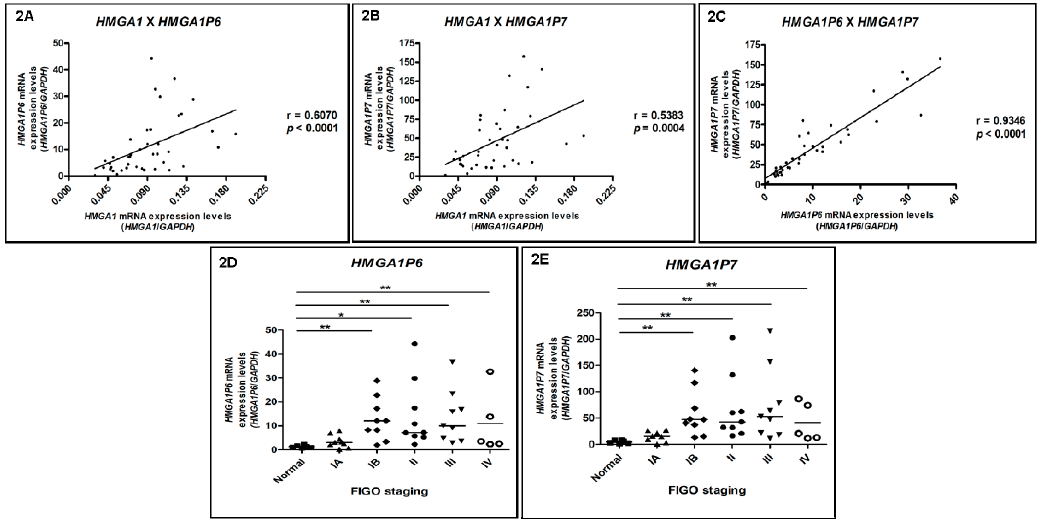
Figure 2. HMGA1-P6 and HMGA1-P7 mRNA expression pattern in endometrioid endometrial adenocarcinomas (EEC). Correlation of HMGA1 mRNA expression with those of HMGA1P6 and HMGA1P7 and evaluation of their expression, according to clinicopathological characteristics, by qRT-PCR. HMGA1P6 and HMGA1P7 gene expression was performed in six normal endometrial